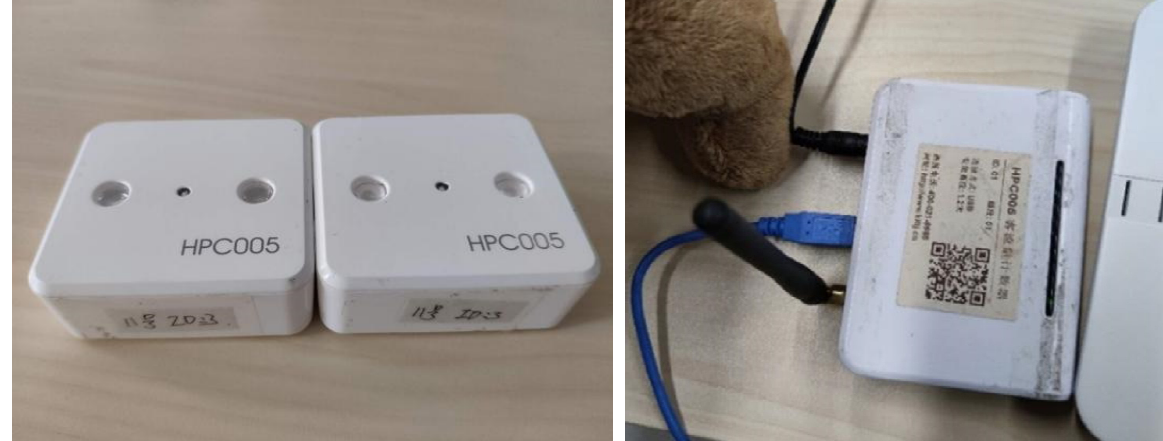
Figure 5. Infrared counters (pair).